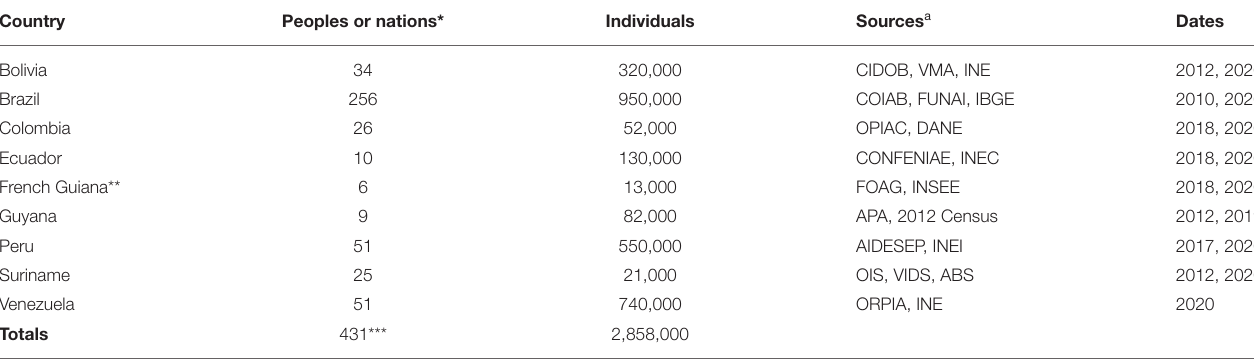
TABLE 1 | Indigenous peoples and estimated populations in the Amazon countries.